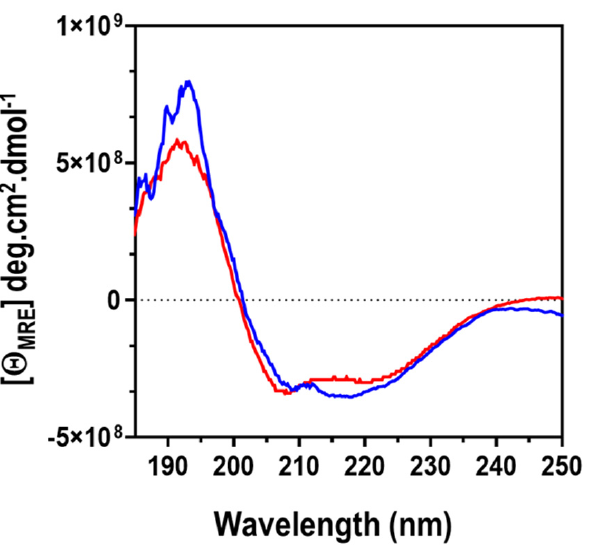
Figure 16 . Far-UV CD spectroscopy of ClpK in the presence and absence of ATP . CD spectra of ClpK (2 µM) at pH 7.4 in the presence of 0.2 mM ATP (blue spectrum) and in the absence of ATP (red spectrum). Each spectrum represents an average of five accumulated spectra derived at 20 °C using a 2 mm path length quartz cuvette.